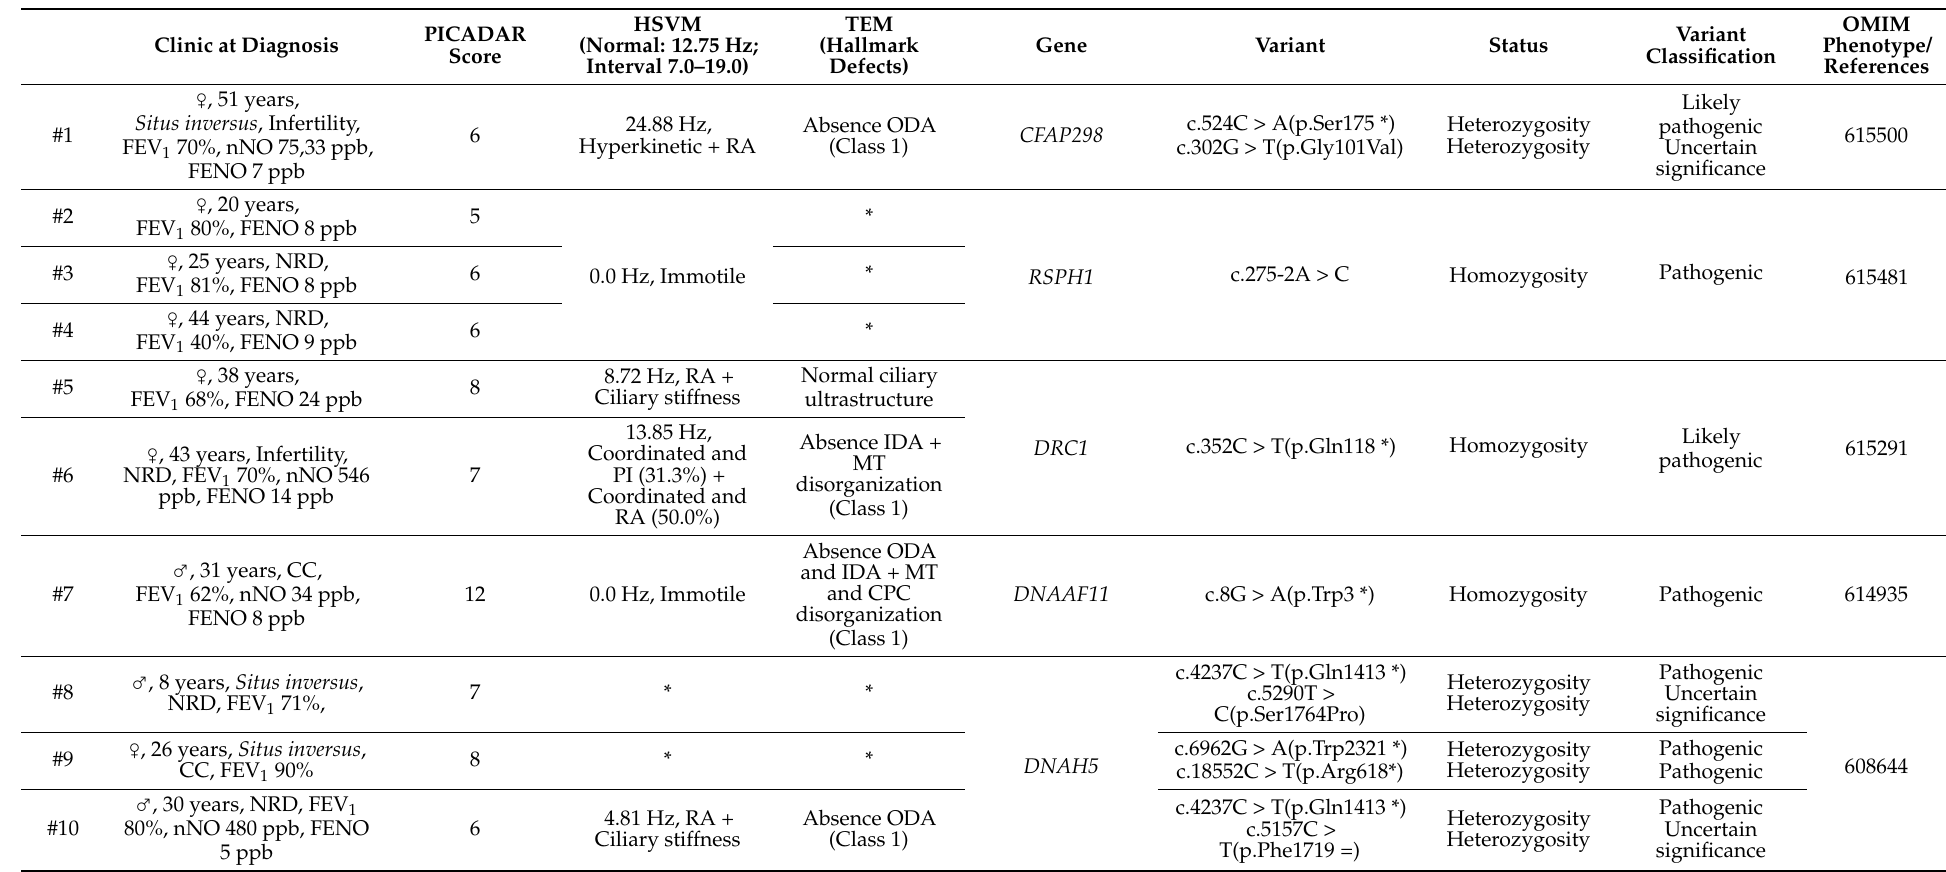
Table 2. Primary ciliary dyskinesia patients and their associated relevant diagnostic